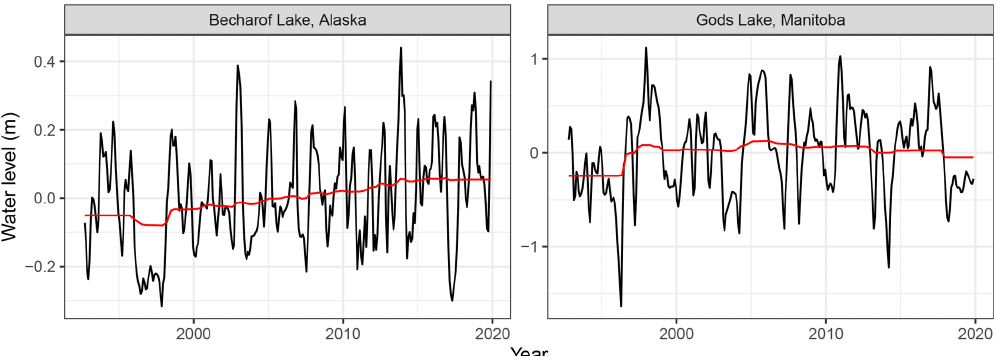
Figure 7. Water level time series for two North American lakes which show the potential for background climate variation to mask long-term trends (Becharof Lake) and the potential for climate variation to give rise to the false appearance of long-term trends (Gods Lake). The water level trend in Becharof Lake in Alaska became more significant after accounting for background climate variation, and the water level trend in Gods Lake in Manitoba became less significant after accounting for background climate variation. Raw data are shown here, but all trends were calculated based on annual averages. The black line is the raw water level data, and the red line is the partial dependence of water level on the year term in the boosted regression